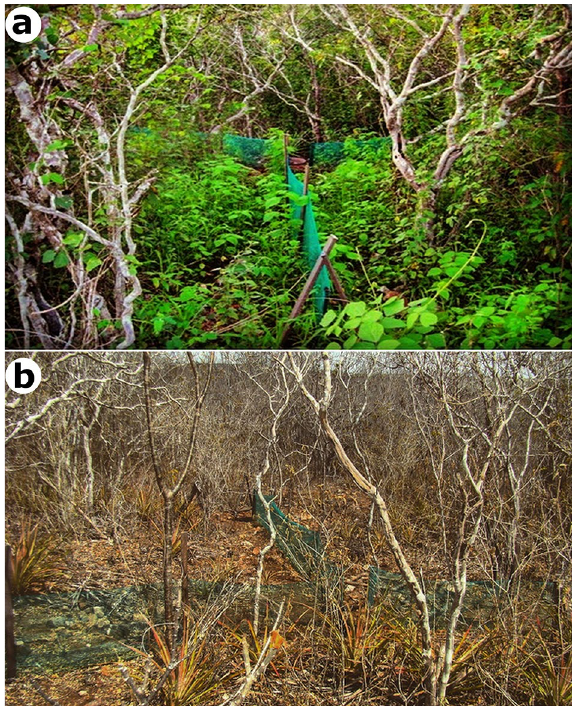
Figure 3. Overall characterization of landscape change due to seasonality at the Grota do Angico Natural Monument–GANM, Sergipe, Brazil. ( a ) Experimental site during the rainy season and ( b ) Same experimental site during the dry season. All photographs taken by Anthony